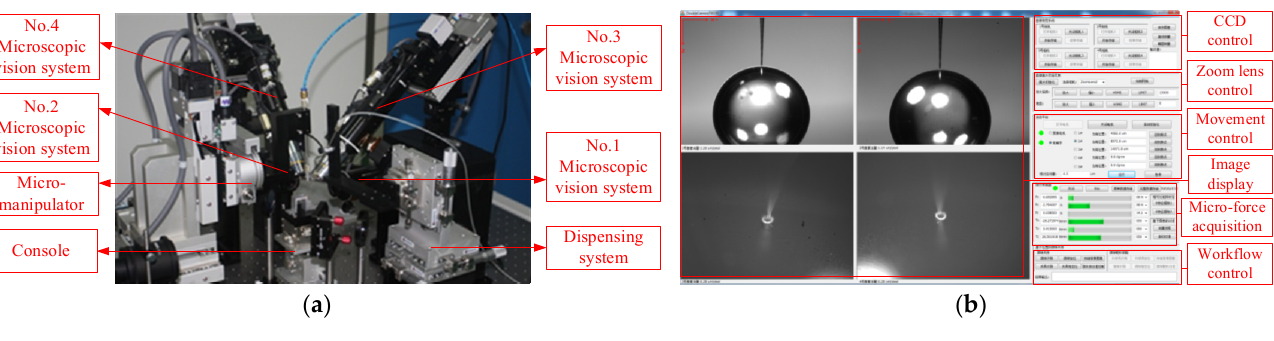
Figure 2. Micro-assembly robot system: ( a ) structure of micro-assembly robot; ( b ) the operation interface of software control system.